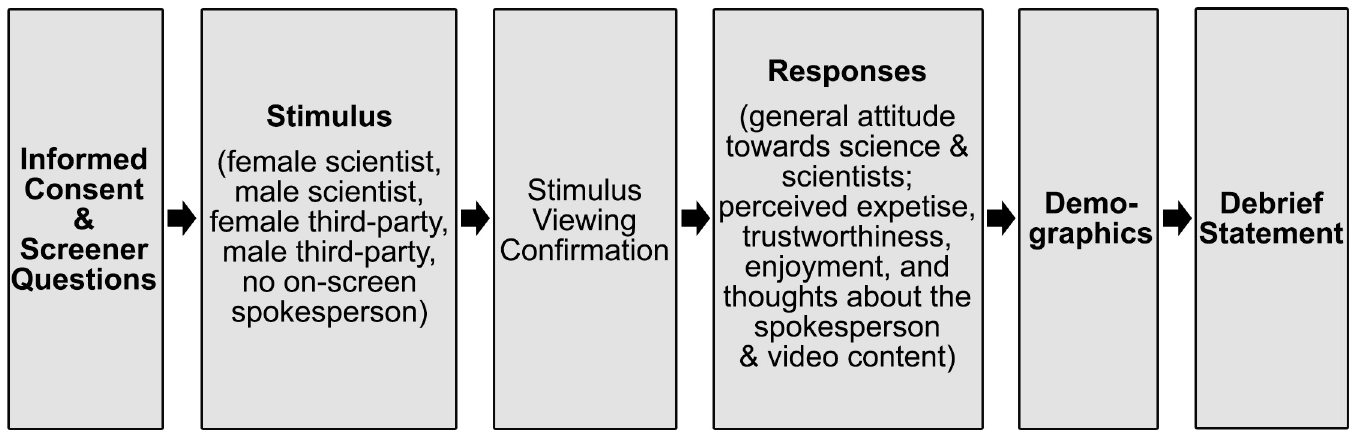
Fig 1. Experimental design. Participants were randomly assigned to one of the five video stimuli in equal